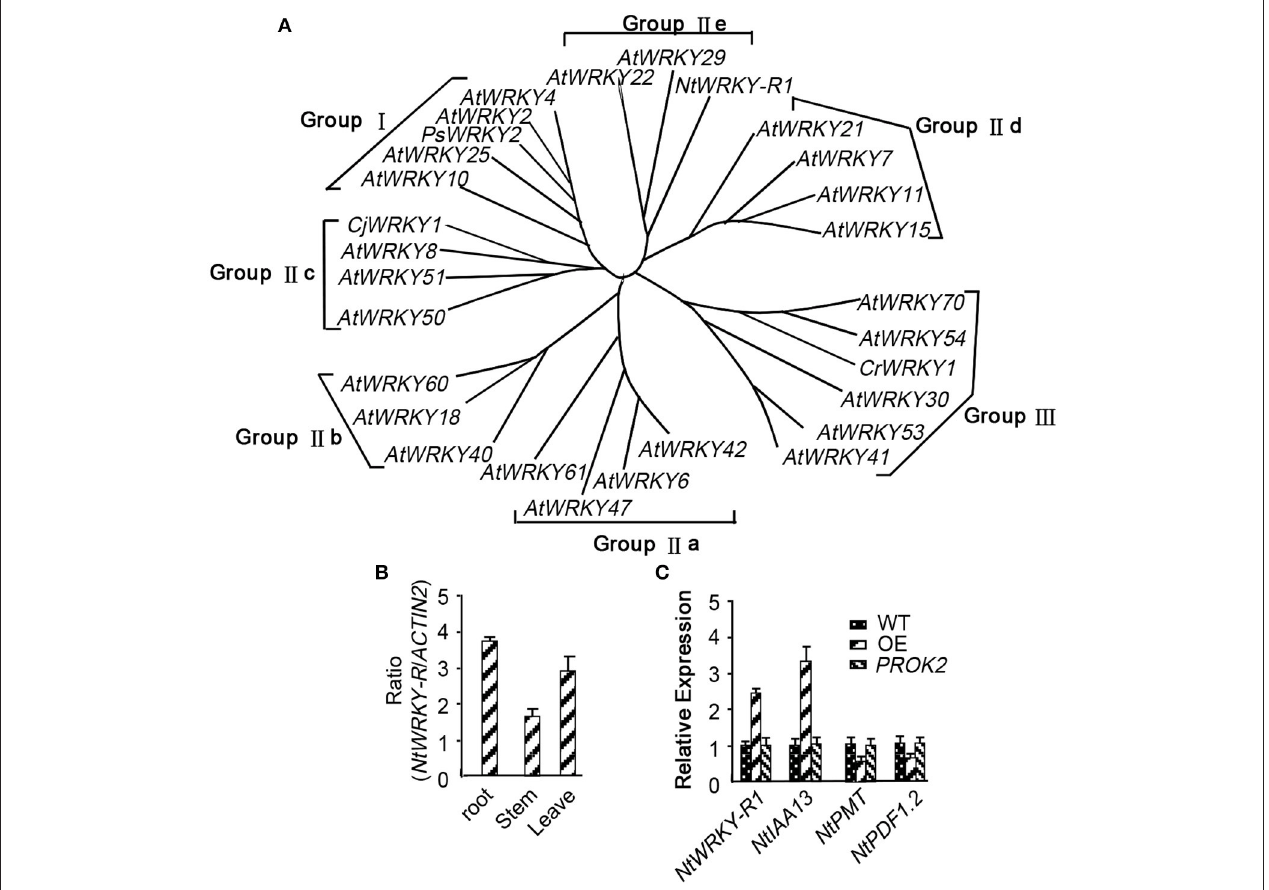
FIGURE 3 | The phylogenetic analysis and expression pattern identification of NtWRKY-R1. (A) The phylogenetic analysis of NtWRKY-R1 . (B) RT-PCR analysis of NtWRKY-R1 gene expression in the indicated Nicotiana tabacum tissues. Total RNA was isolated from roots, stems and leaves. Data were means ± SD of three biological replicates. (C) The effect of over-expressed NtWRKY-R1 on the expression of PMT, IAA13, and PDF1.2 . WT is tobacco leaf mesophyll-derived protoplasts. OE is tobacco leaf mesophyll-derived protoplasts transformed by NtWRKY-R1 with the 35S promoter. PROK2 is tobacco leaf mesophyll-derived protoplasts transformed by empty